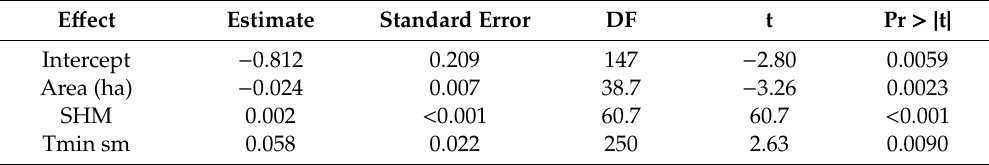
Table 6. Final multivariate model relating the percentage of dry stream-reach length to basin area, summer heat:moisture index (SHM) and mean minimum summer temperature (Tmin sm). Conditional R 2 = 0.82 and marginal R 2 =